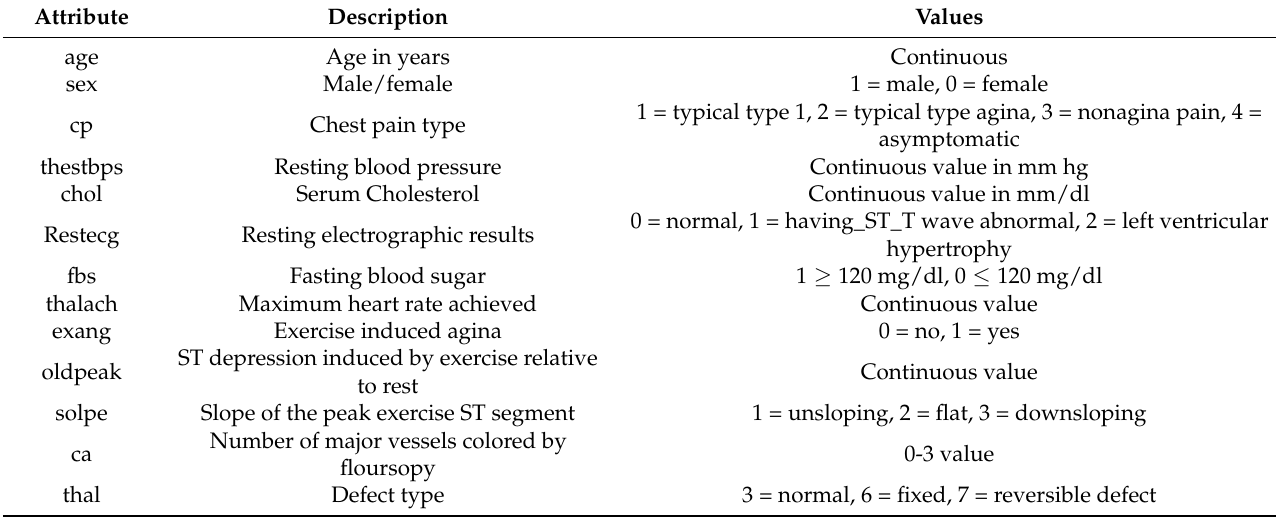
Table 3 summarizes the detailed attributes of the selected features of the heart disease dataset. Table 3. Description of UCI Heart Disease data attributes